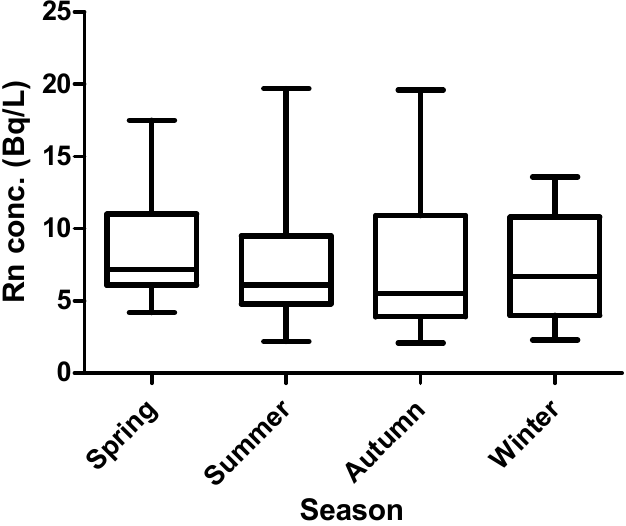
Figure 3. Seasonal (season) distribution of radon activity concentration (Bq/L) in 29 Romanian karstic springs surveyed during 2019–2020.